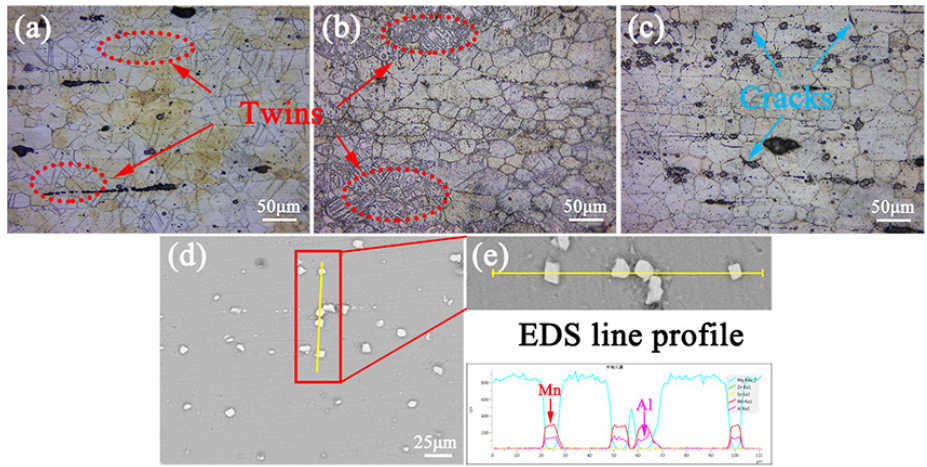
Figure 10. Optical images ( a – c ) and SE-SEM ( d ) from longitudinal sections of the single-aged ZTM641-xAl alloys adjacent fracture surface tested at room temperature, ( a ) x = 0, ( b ) x = 0.5, ( c , d ) x = 2 alloy and ( e ) EDS line profile in ( d ).